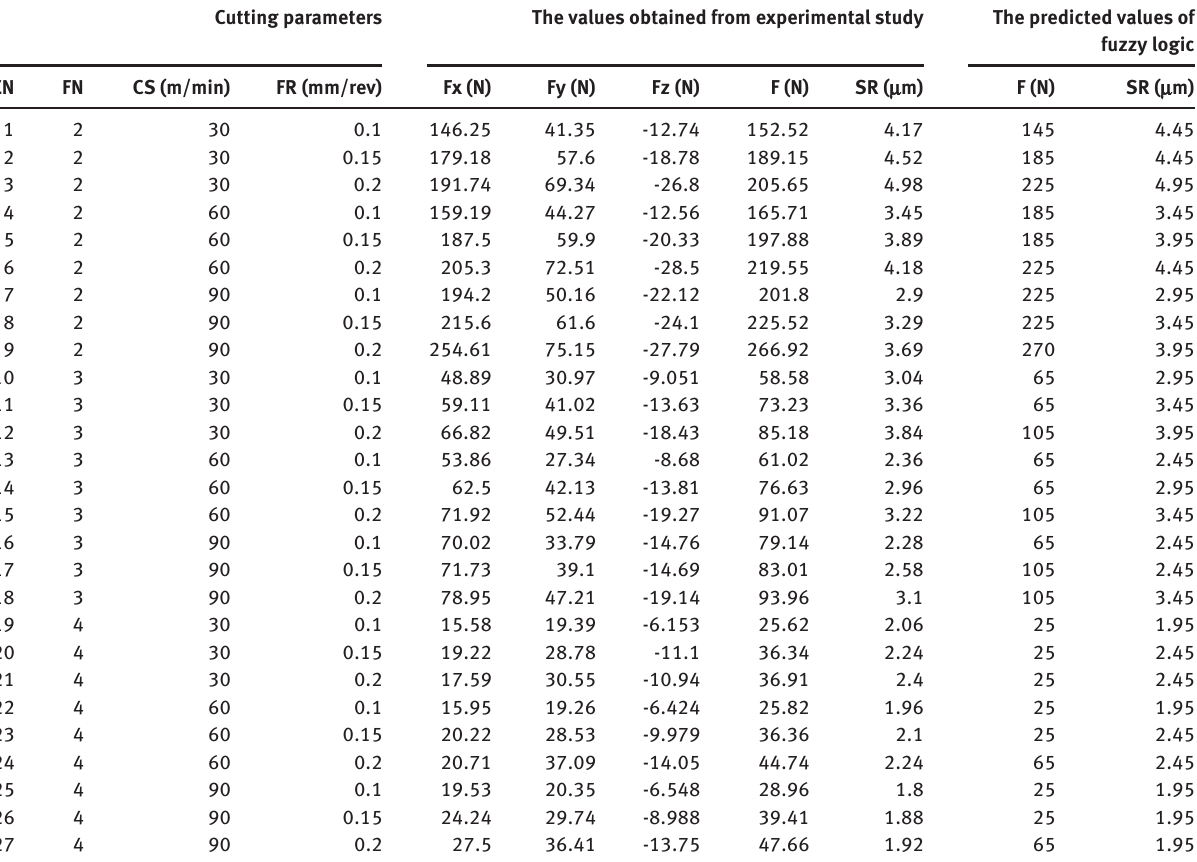
Table 3 Cutting parameters with the values both obtained from the experimental study and the predicted fuzzy logic model. Cutting parameters The values obtained from experimental study The predicted values of